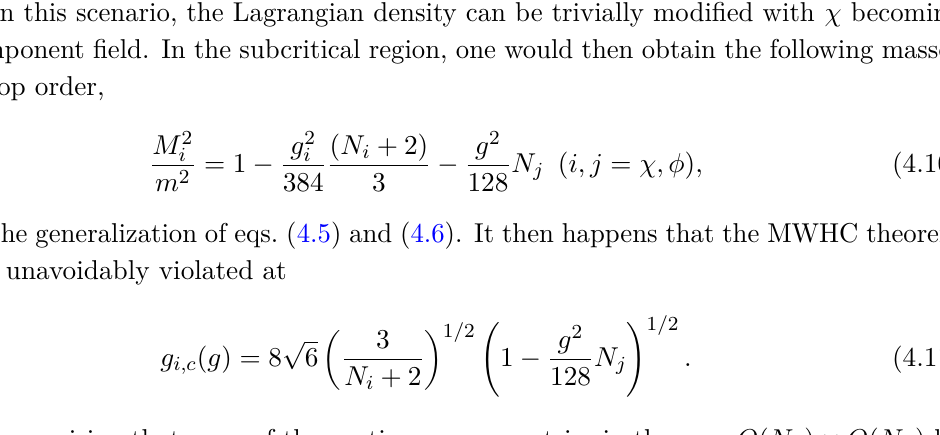
/m 2 . The parameters are chosen susch as g χ = 20 | g | and φ